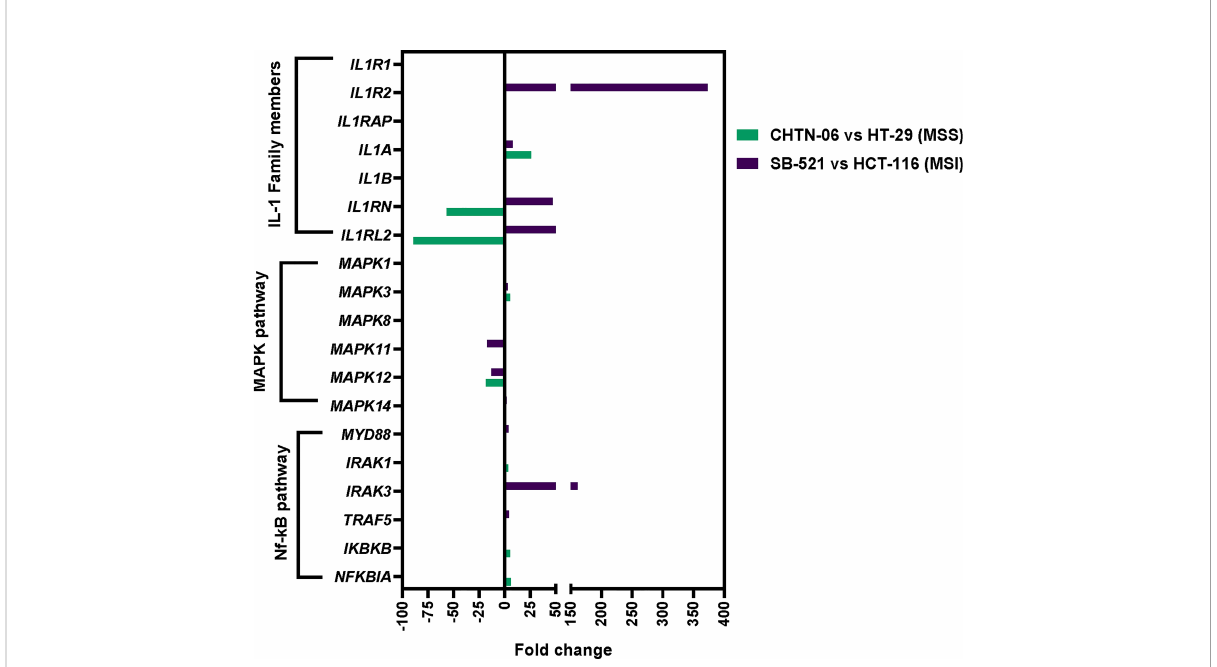
FIGURE 1 Differential gene expression of ILB , MAPK , and NFKB related genes between AA and CA colon cancer cell lines. Cell lines have been grouped based on their microsatellite status in MSS (CHTN-06 vs. HT-29) and MSI (SB-521 vs. HCT-116). Graphical representation of fold change of genes compared between cell